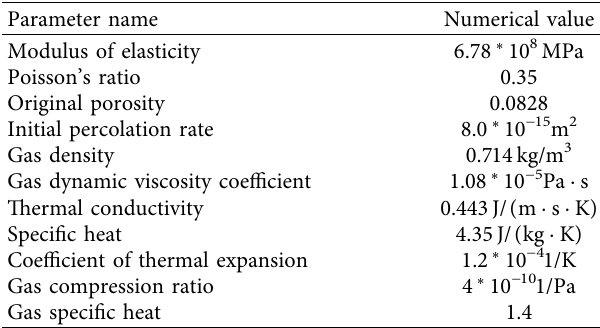
Table 5: The material parameters of the